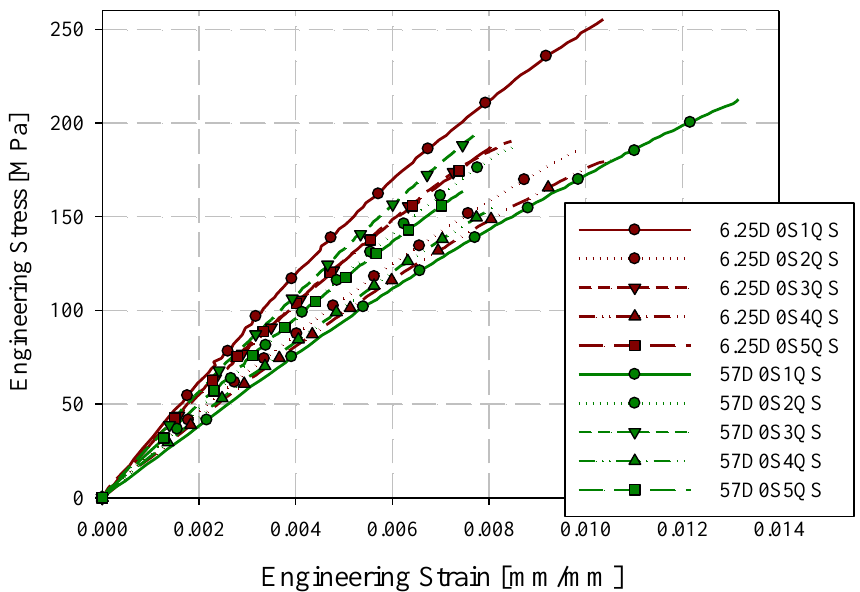
Figure 7. 0-degree quasi-static engineering stress-strain responses ASTM D638 type III and reduced gauge length (6.25 mm) specimens.